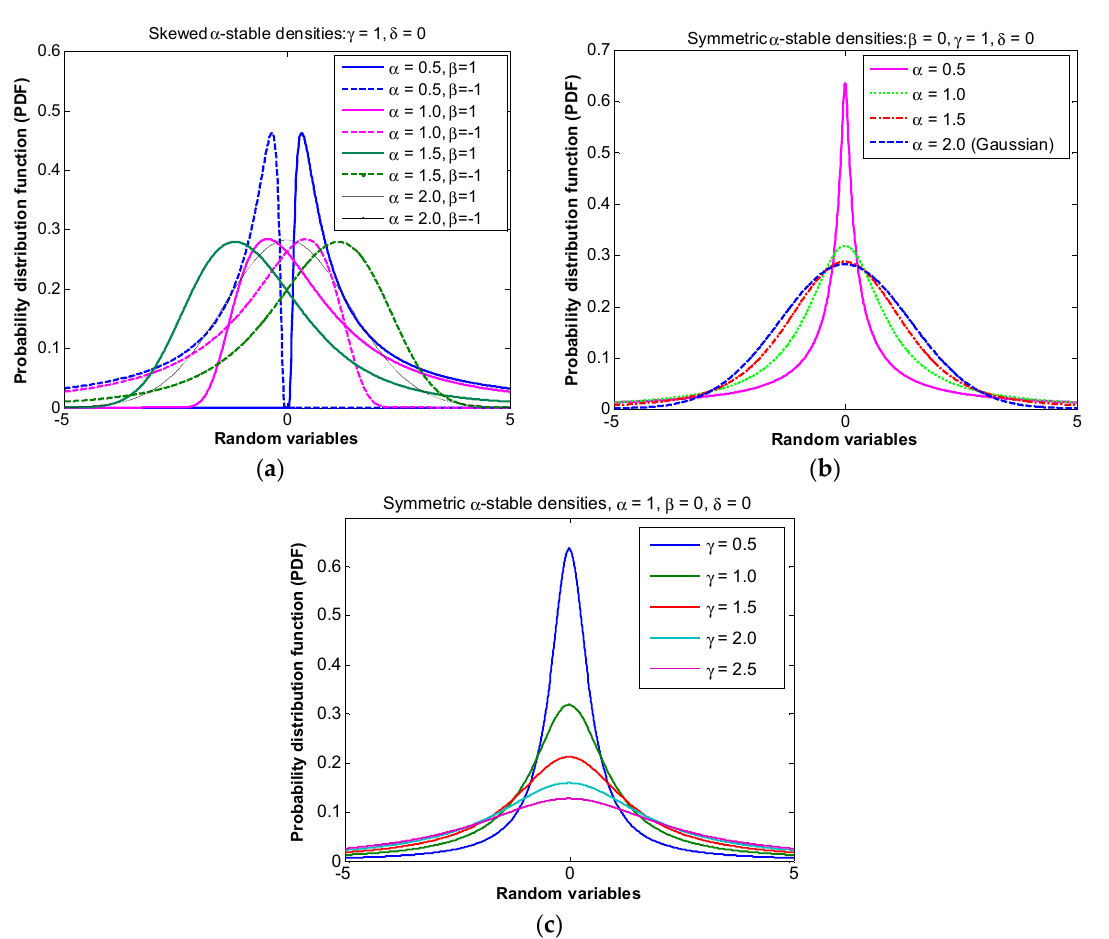
Figure 1. PDF comparisons of α -stable noise: ( a ) symmetric distribution; ( b ) skewed distribution; ( c ) scale distribution.